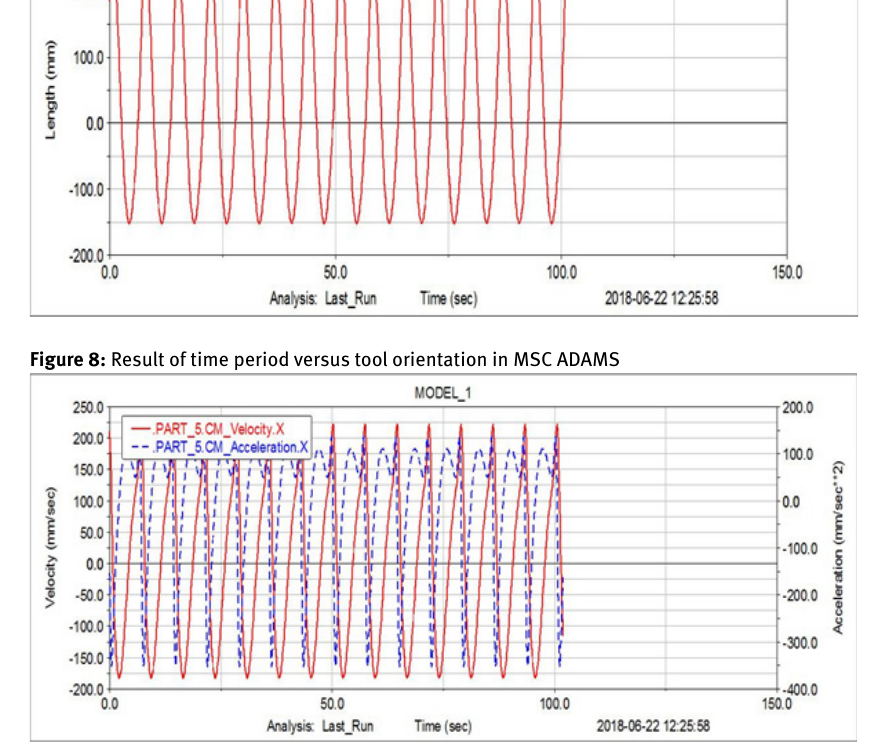
Figure 9: Result of time period versus tool velocity and acceleration in MSC